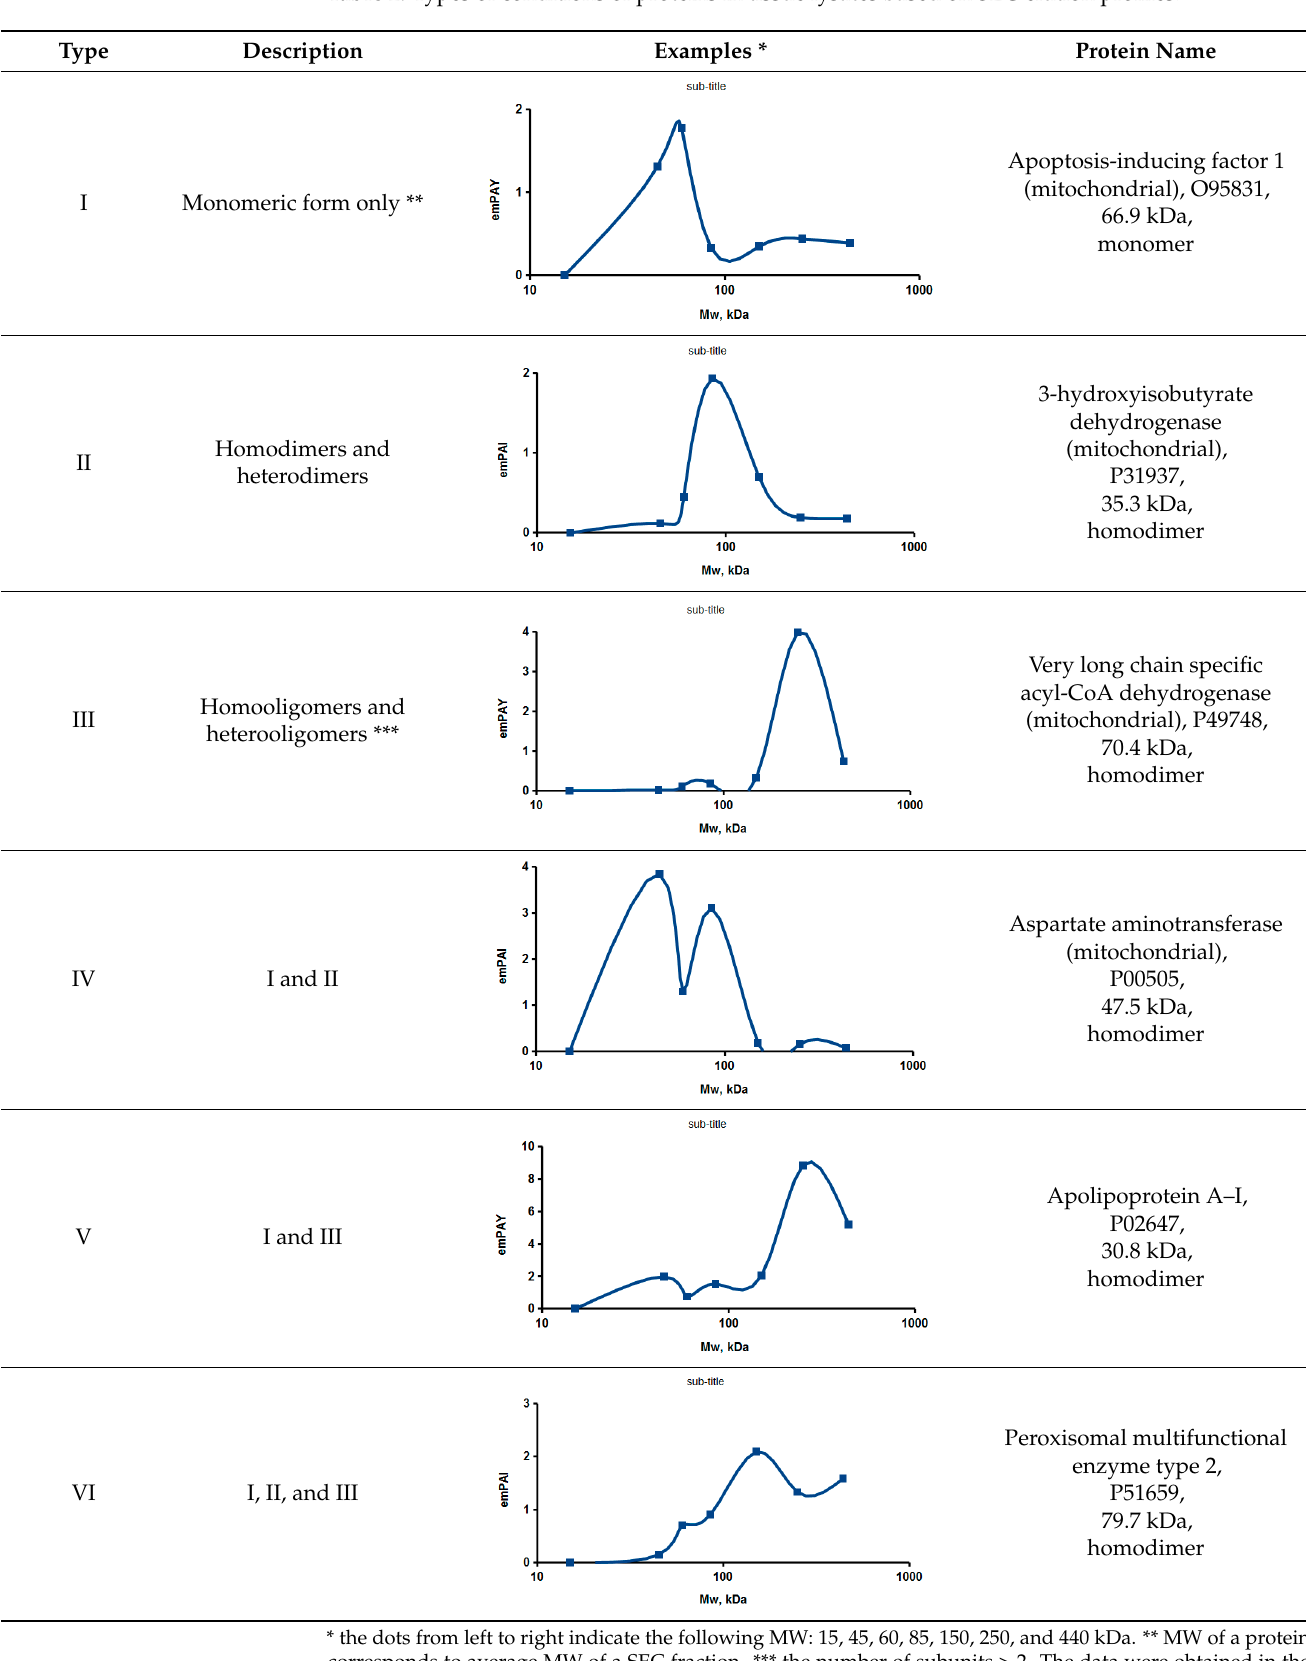
Table 2. Types of conditions of proteins in tissue lysates based on SEC elution